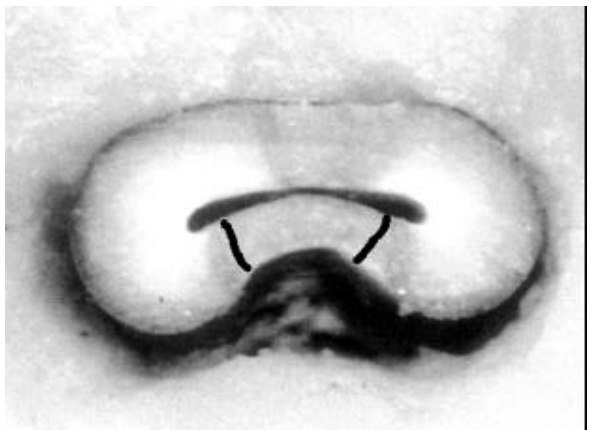
FIGURE 1 - Danger zone in the mesial roots of mandibular molars